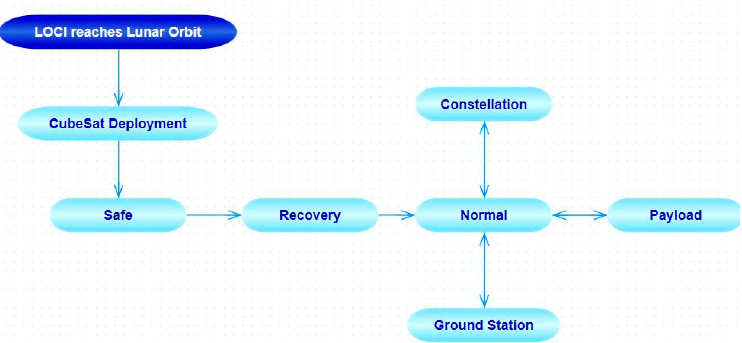
Figure 2. Mission Scenario.